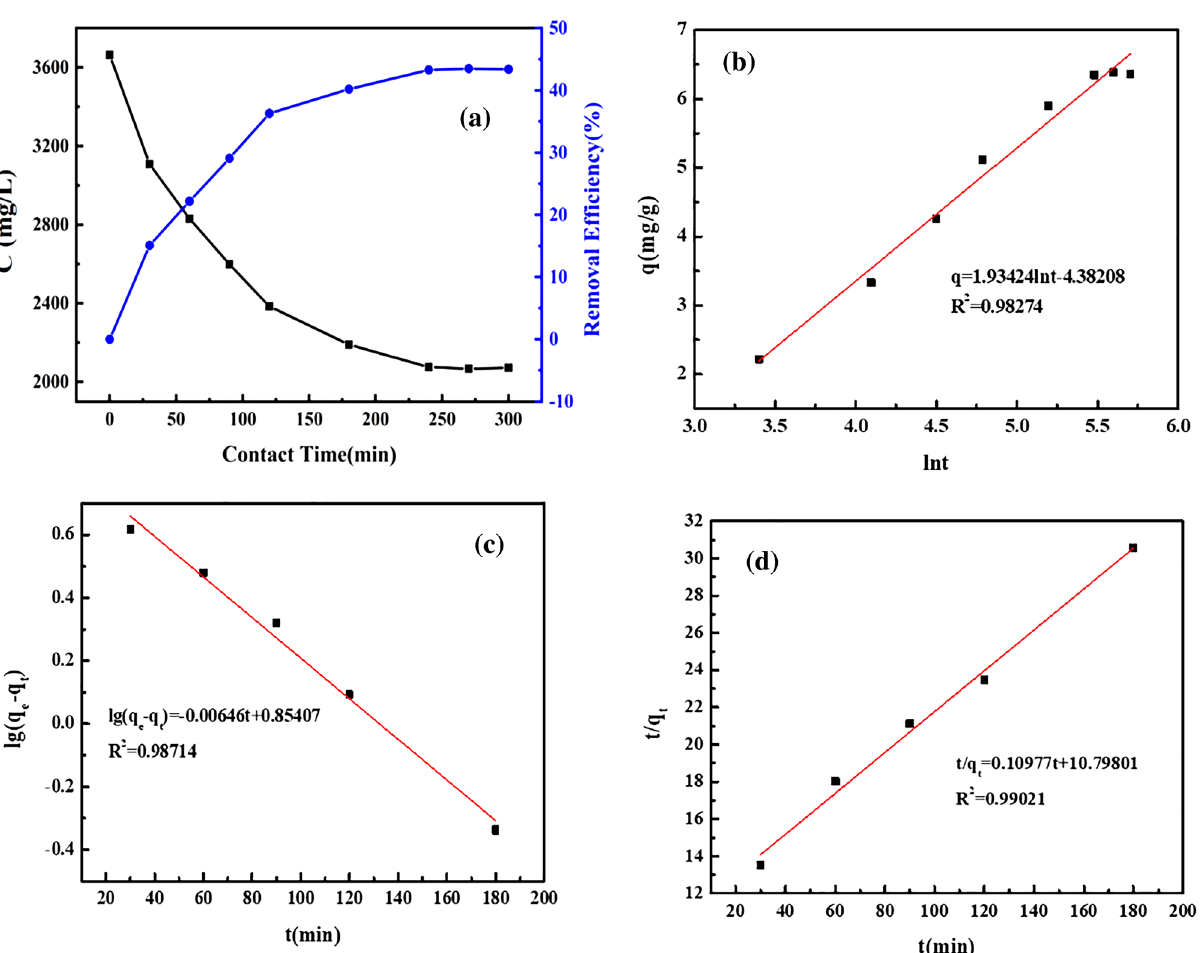
Figure 5. Curve of adsorption capacity and removal rate with time ( a ); Elovich dynamic model curve ( b ); Pseudo first-order dynamic model curve ( c ) and pseudo second-order dynamic model curve ( d